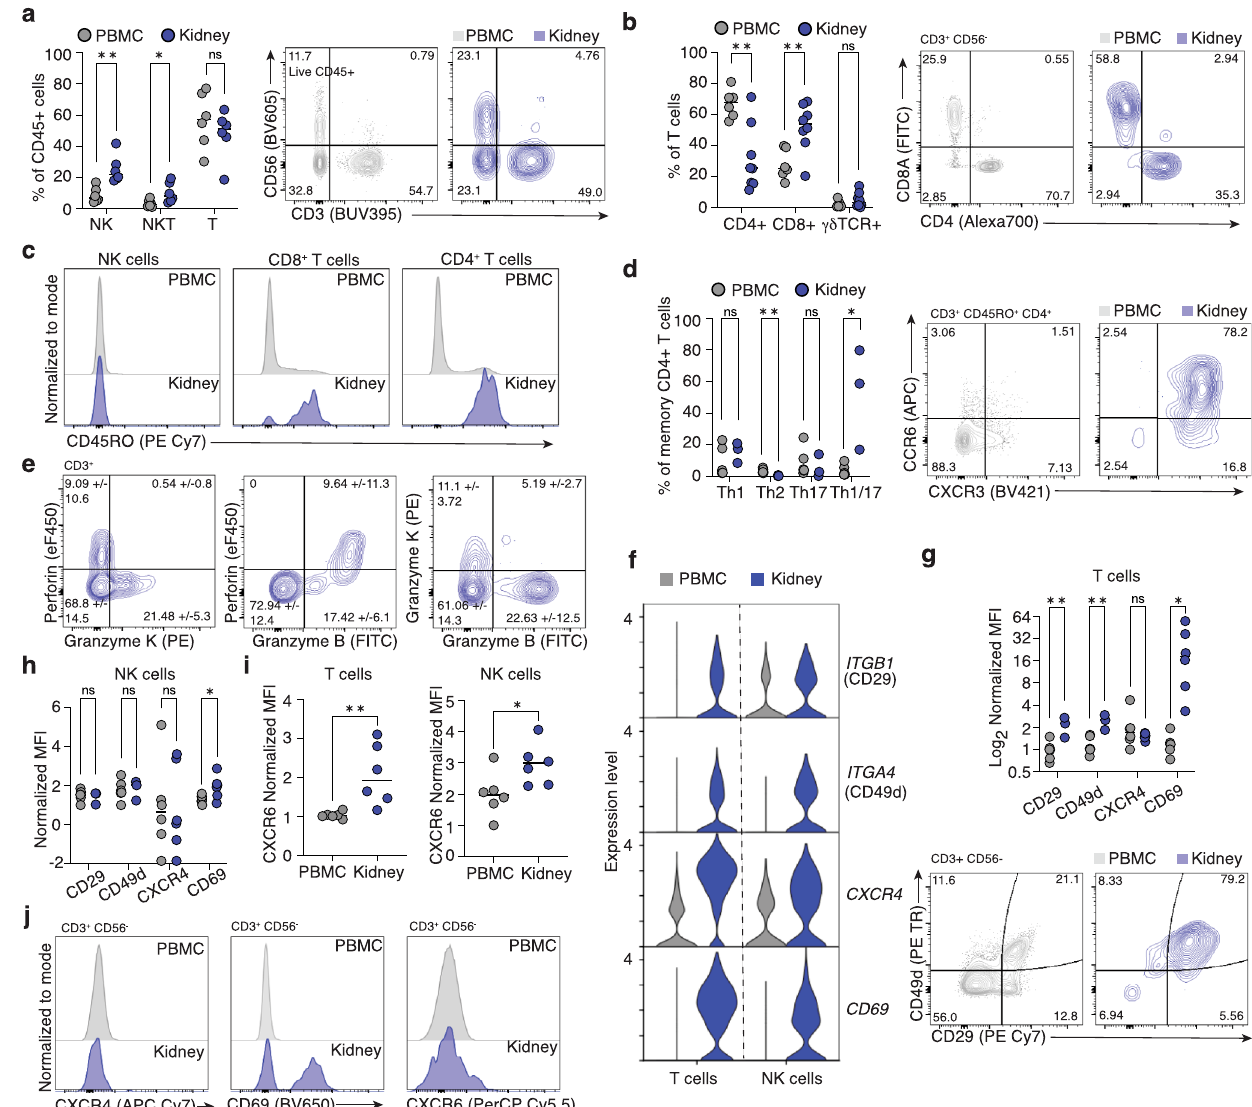
Fig.5|Characterizationofkidney-residentTandNKcells.a NKcells( p =0.0025, t=3.998, df=10) and NKT cells ( p =0.0327, t =2.476, df=10) are proportionally enriched in kidney relative to blood, while T cell (p =0.379, t=0.918, df=10) abundanceisunchanged.( n =6)( b )WithinthekidneyTcellpopulation,thereisan enrichmentof CD8 + Tcells (p =0.0060, t =3.327,df=12)andareductioninCD4+T cell abundance ( p =0.0025, t =3.815, df=12) with no change in TCR γδ + T cells ( p =0.2158, u =14) relative to blood. ( n =6) ( c ) Kidney T cells are predominantly antigen-experienced, marked by expression of CD45RO, while NK cells express minimal CD45RO. d Within kidney memory CD4 + T cells, there is an enrichment in